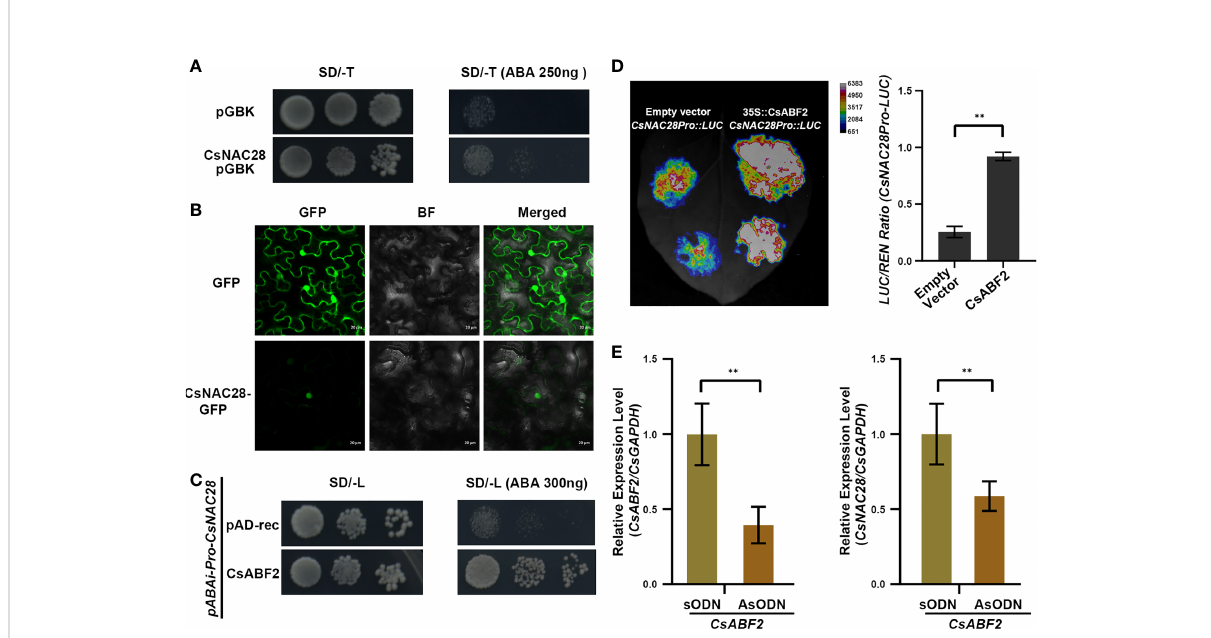
FIGURE 6 The potential function of CsNAC28 in tea plant. (A) Transactivation analyses of CsNAC28 in yeast. Negative control, and the fusion constructs were transformed into the Y 2 H strain and successively incubated in SD/-Trp media and SD-Trp/ABA (250ng) plate. (B) Subcellular localization of CsNAC28. GFP and CsNAC28-GFP were transiently expressed in tobacco leaves. GFP, Green fl uorescence image; BF, Bright- fi eld microscopy image; Merge, Merged bright- fi eld and green fl uorescence images. (C) Yeast one-hybrid assay to con fi rm binding of CsABF2 to the CsNAC28 promoter. (D) Relative LUC/REN ratio from transient expression assays of the CsNAC28 promoter in the present of CsABF2. Error bars indicate the SD of three biological replicates. (E) CsABF2 and CsNAC28 expression in control ( CsABF2/ sODN) and CsABF2/AsODN tea leaves. Error bars indicate the SD of three biological replicates. **Student ’ s test, P <